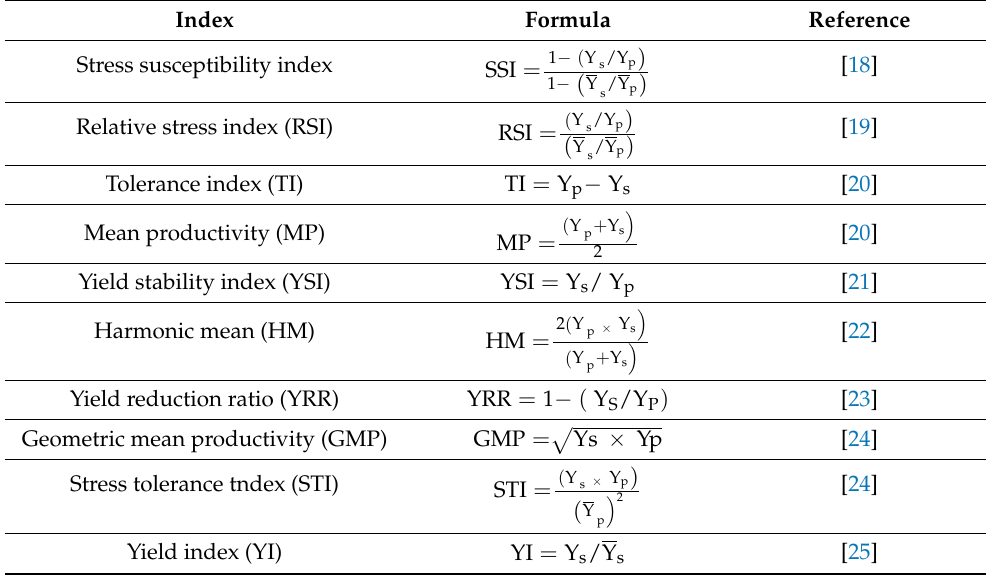
Table 3. Some mathematical formulas of tolerance and susceptibility indices for grain yield.